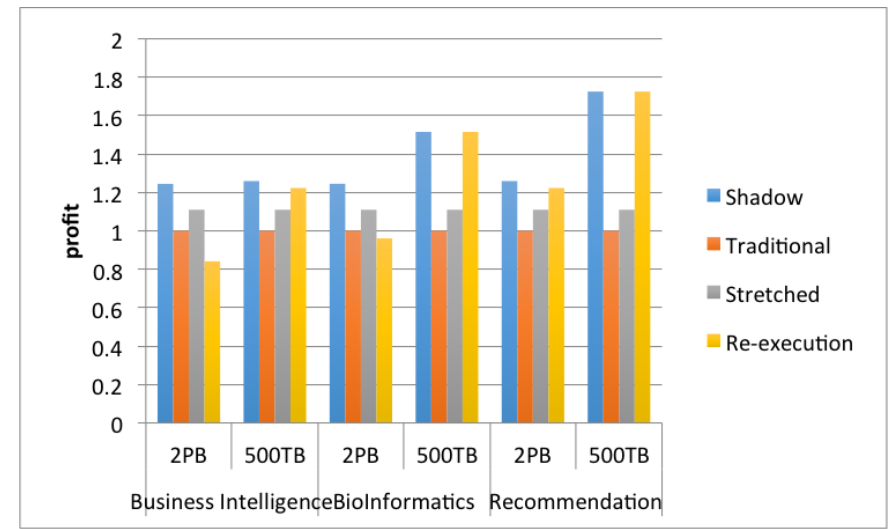
Figure 7. Application comparison. ρ = 0.5, MTBF = 5 years, N = 500 , 000 , t t = 2 . 6 t R 2 min